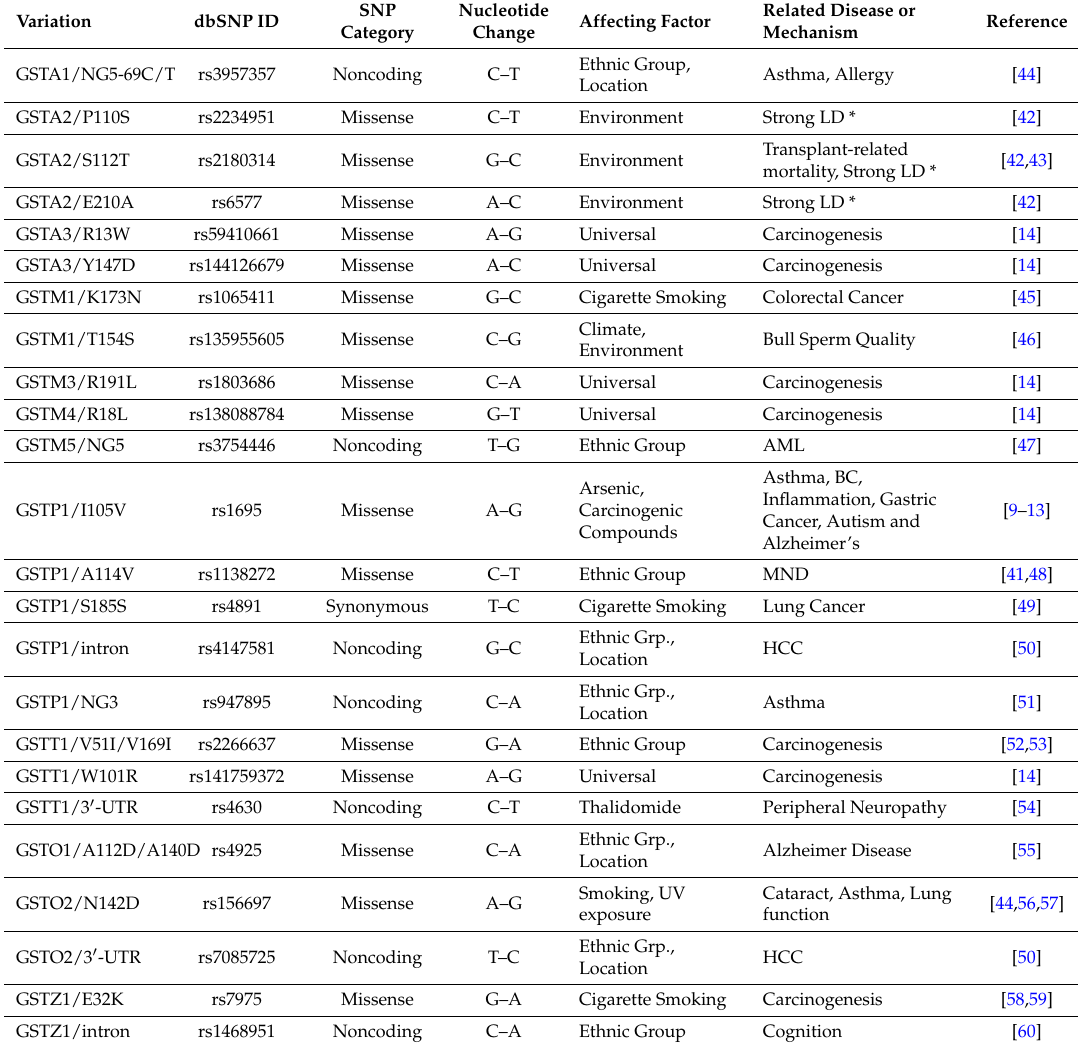
Table 3. Significant GST SNPs related to miscellaneous diseases or